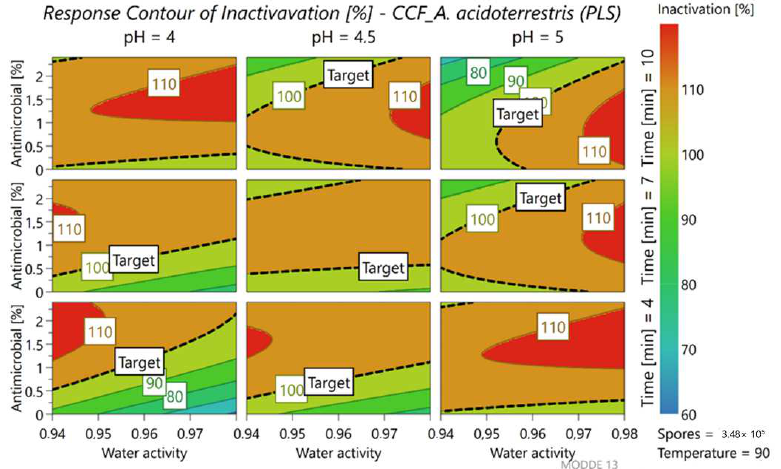
Figure 4. Contour plot representing the percent of spore inactivation of A. acidoterrestris LMG 16906, at different levels of parameters.